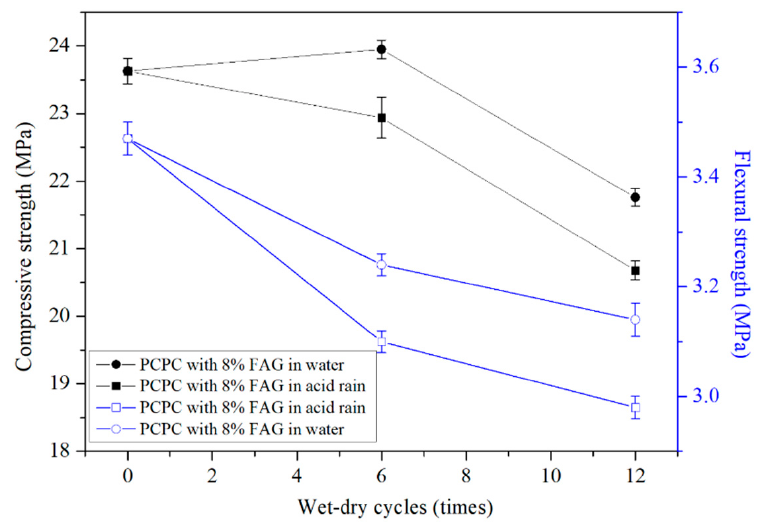
Figure 6. Strength of PCPC with 8% FAG.